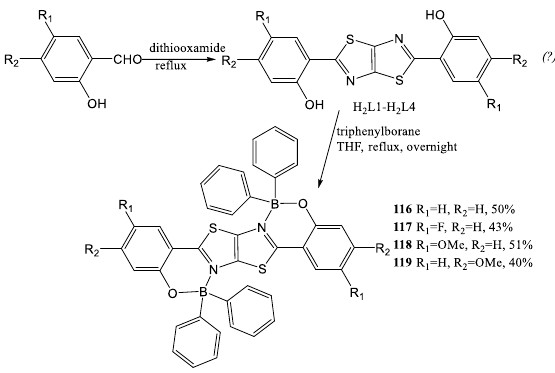
Figure 21. Design of a strategy toward a diboron-containing ladder 115 .